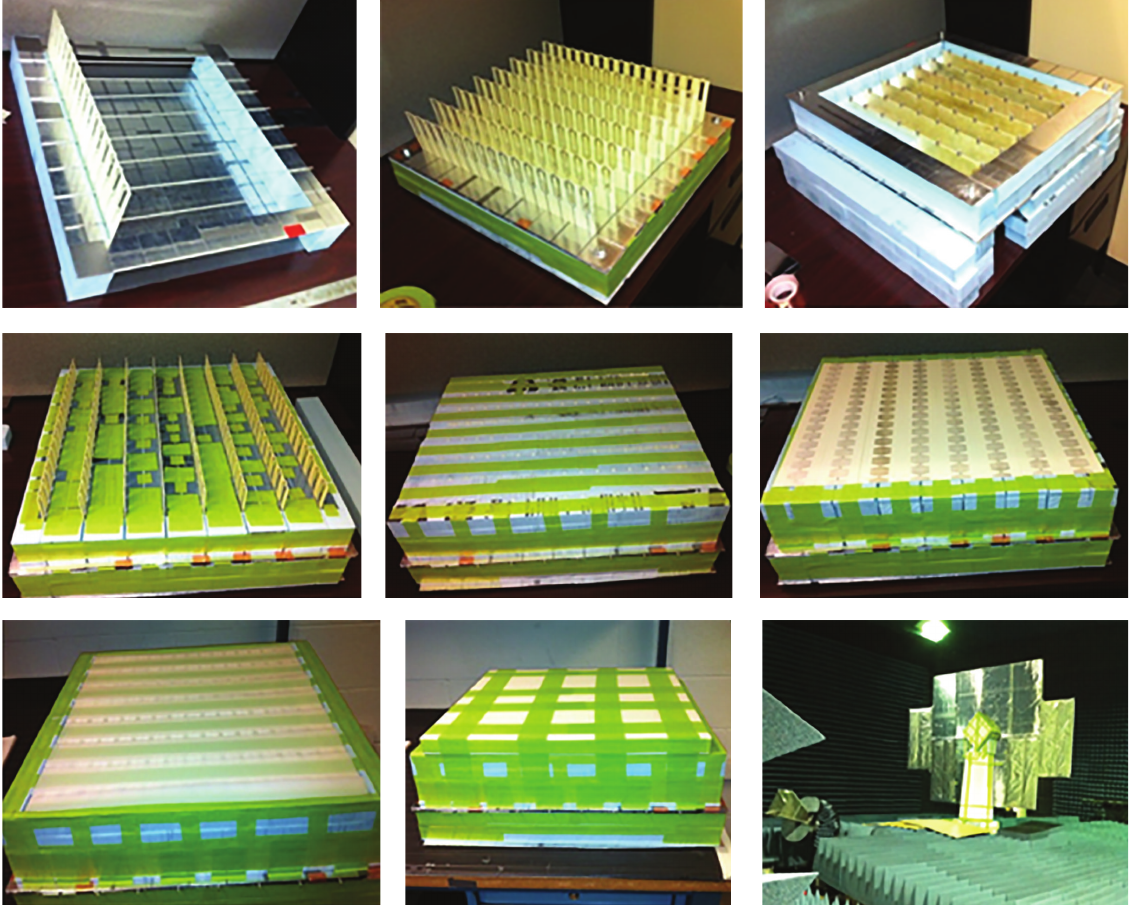
Figure 10: Fabrication stages of the TCDA-IB array depicted in Figures 5–9. The lower right figure refers to the measurement setup in the Ohio State’s compact range. The feeding antenna during measurements is a linearly polarized horn as the array itself is also linearly polarized. Note that the array was measured in the presence of a metallic ground plane of 360 cm × 240 cm in